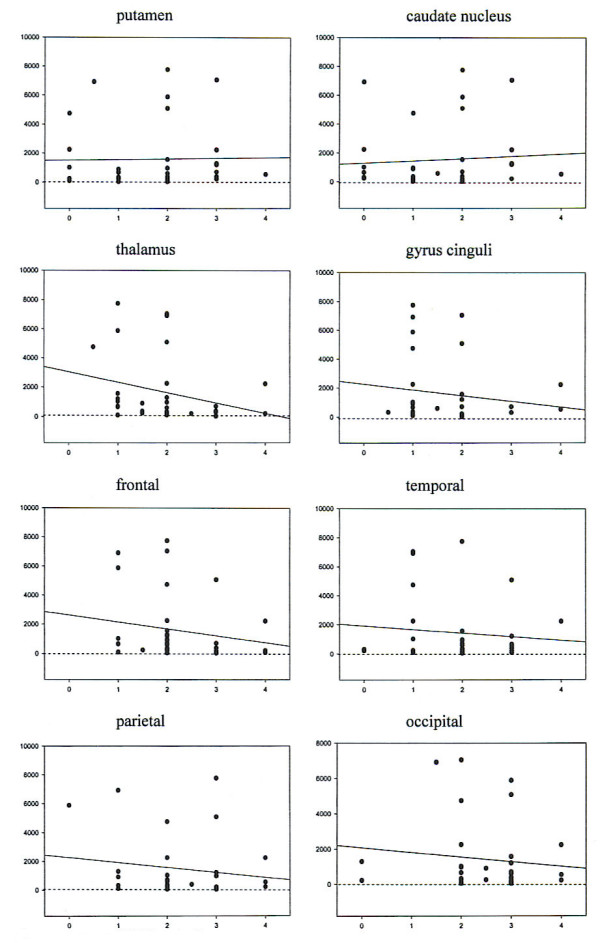
Correlation between 14-3-3 CSF levels and degree of neuronal loss in various brain areas. (- - - - - - cut-off 200 ng/ml).